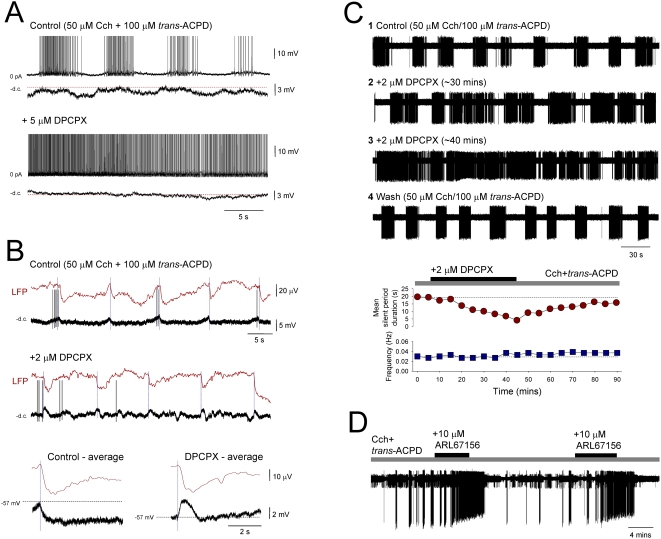
The long-lasting rhythmic hyperpolarizing potentials reflect activation of A1 receptors by ATP-derived adenosine.A. Complete block of the ISO in an LGN TC neuron following application of the A1 receptor antagonist DPCPX (5 µM). B. Top panel: simultaneous LFP and intracellular TC neuron recording of the ISO in the LGN. Below: DPCPX disrupts the expression of the ISO in the intracellular recording but not in the LFP. This is more clearly illustrated by the membrane potential averages shown below which reveal that the long-lasting hyperpolarizing potentials observed prior to DPCPX application (left) are abolished and replaced by a shorter lasting (∼1 s) depolarizing event (right). C. Plots showing the effect of DPCPX on the mean duration of the silent period (top) and the overall frequency (bottom) of an ISO observed with an extracellular single unit recording in the VB in the presence of 50 µM Cch. D. Extracellular single unit recording of a VB TC neuron exhibiting the ISO in the presence of 50 µM Cch. The ecto-ATPase inhibitor ARL67156 reversibly converts the ISO into continuous firing. (action potentials have been truncated in A and B).